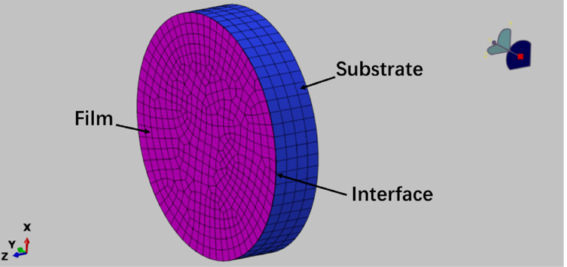
Figure 1. 3D finite element model of film/substrate structure: the left end surface is alumina thin film and the right four layers mesh is the substrate, a cohesive element is inserted into the interface. The mesh division at the boundary is